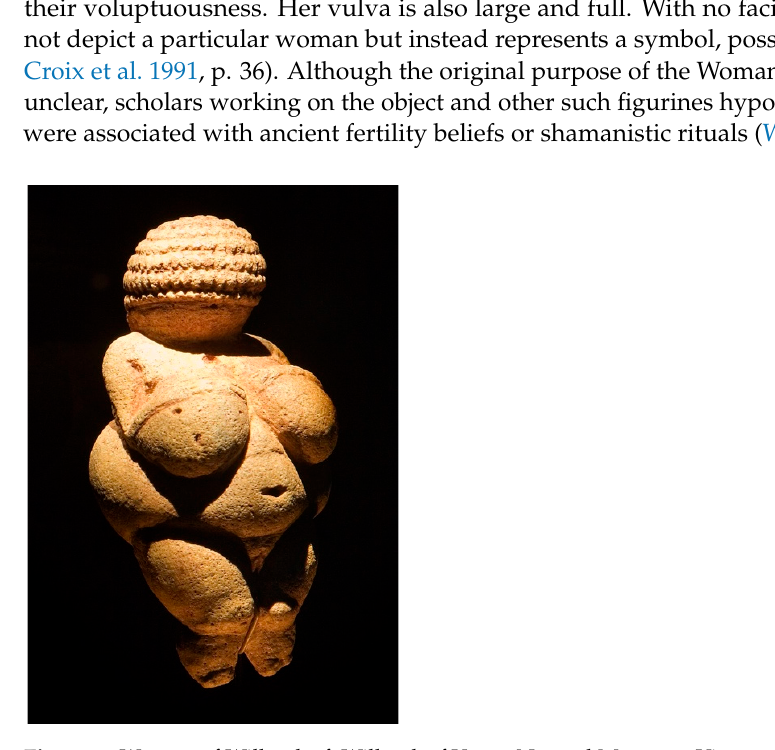
mation on birth in New Zealand, the figurine appears alongside the text that the object simply, “honours women’s birthing abilities.” As in the case of the Virgin Mary, a mother figure who is widely revered in the birth community but not discussed in this paper, nu- merous Pinterest pages providing viewers with images related to pregnancy and birth include the Woman of Willendorf. Through Pinterest, visitors can also link out to various shopping websites where they can purchase pendants and jewelry of the Woman of Wil- lendorf as related to childbirth and pregnancy. Similarly, Facebook posts associated with childbirth education, doula, or midwifery service show the figure of the Woman of Wil- lendorf and describe the object as a symbol of fertility and birth. Numerous items marketed as Woman of Willendorf necklaces, figurines, pendants, and charms are also used in the context of fertility, pregnancy, and birth, often understood as sacred objects. Joanna Hajduk, a Polish artist who creates stone statuettes of the Wil- lendorf figure, for example, describes her recreations as “shamanic figurines,” to be used in relationship to fertility or the rituals of birth, and particularly as part of a sacred birth altar. Another artist, Jenna Danielle, sells printable adult coloring pages of the Woman of Willendorf, which she states can be used by women or by doulas who are helping other women prepare for birth as a way of celebrating a woman’s own internal “fertility god- dess.” Other artists create metal or stone charms and jewelry of the figure, selling them through shopping websites such as Amazon and Etsy in the context of sacred birth items. The replicas of the Woman of Willendorf, as well as photos of the original Paleolithic fig- ure, are also found in Pinterest collections devoted to the topic of sacred birth art. In all of these cases, the meaning of the Woman of Willendorf has gone through a transformation. Its function relates neither exclusively to a religious or cultural history, nor to a secular purpose. Instead, there is a collective understanding within the birth com- munity that the object is sacred in the humanistic context of birth and the contemporary rituals of birth. 2.4.3. Labyrinths for Birth Like Pachamama and the Woman of Willendorf, the labyrinth (Figure 3) is an im- portant part of material culture used in the rituals of birth. Unlike a maze, which has mul- tiple sometimes dead-end paths, a labyrinth is unicursal with a single path leading